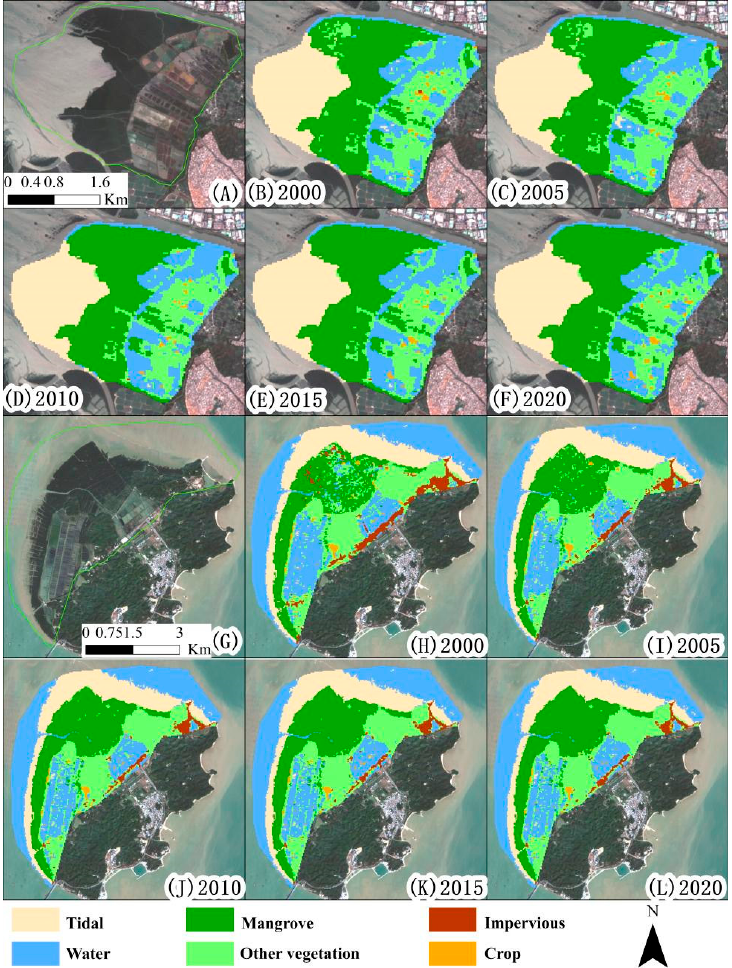
Figure 5. The spatiotemporal changes of mangrove forests in MPMNR ( A – F ) and QIMNR ( G – L ) from 2000 to 2020. ( A , G ): the image of MPMNR and QIMNR, ( B , H ): 2000, ( C , I ): 2005, ( D , J ): 2010, ( E , K ): 2015, ( F , L ): 2020.